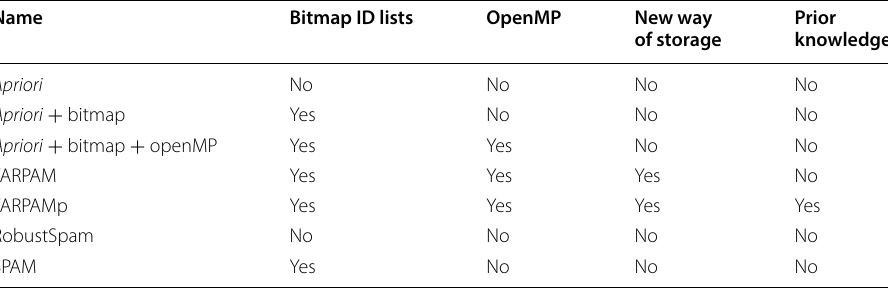
Table 2 Optimisation details of the tested